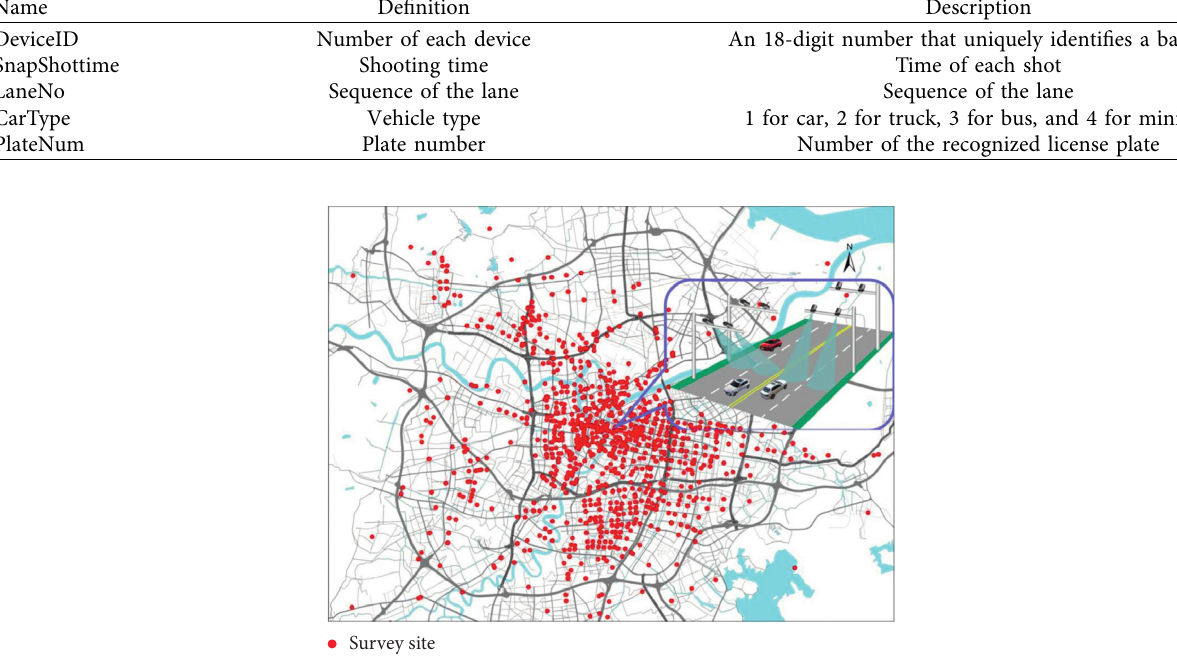
Figure 1: Road network and bayonet distribution on the road. Table 2: Statistics of traffic flow on restricted bridges and intersections